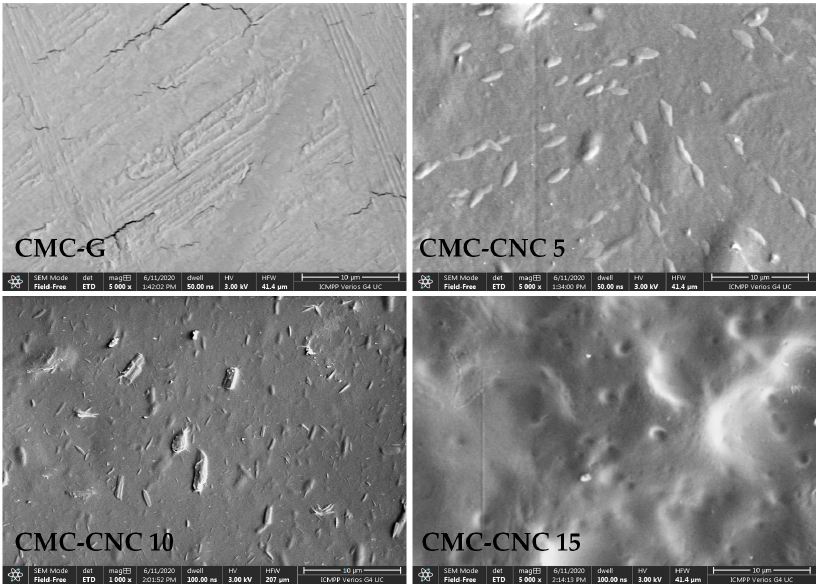
Figure 8. Morphological aspect of CMC and CMC-CNC nanocomposite films.